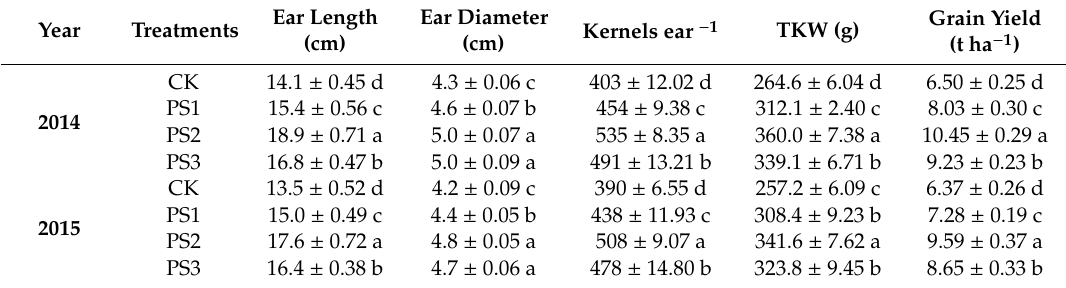
Table 2. E ff ects of paclobutrazol treatments on ear size, grain yield, and yield components of maize during 2014 and